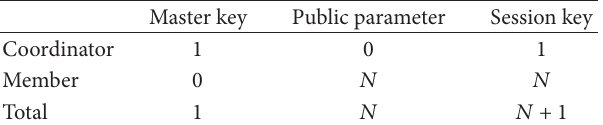
Table 2: Storage.